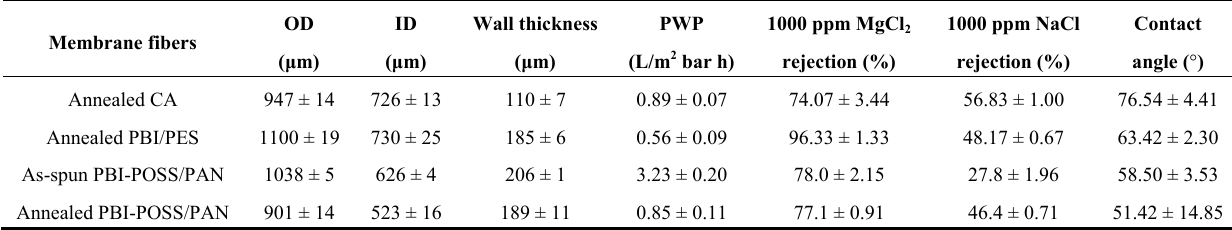
Table 1. Membrane dimension and basic performance characteristics.